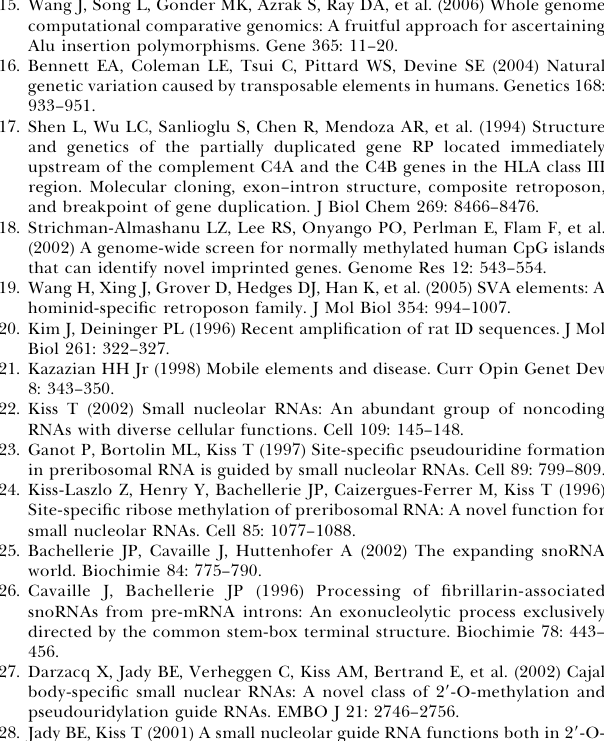
Table S1. Analysis of snoRT